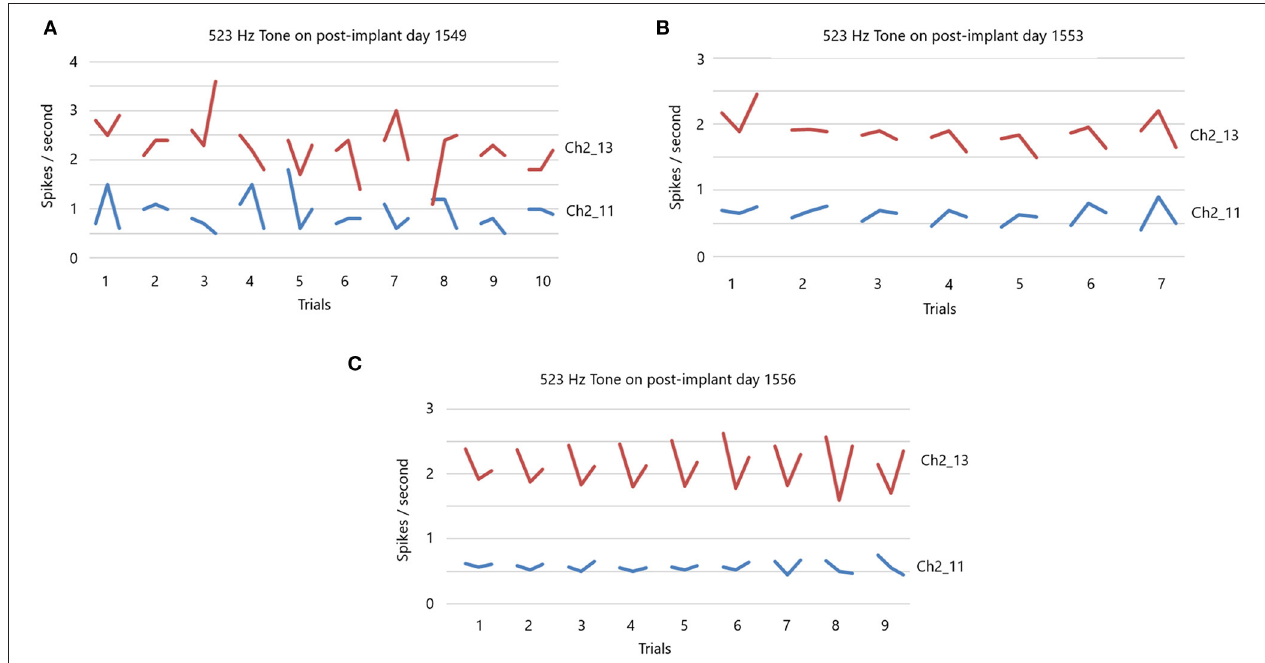
FIGURE 7 | (A) 523Hz tone is presented on post-implant day 1,549. There are 10 trials, with each trial having a 10s “listen” period, followed by a 10s rest period and then a 10s “sing the tone he just heard” period. Note the random firing rates of these slow participant. There is no feedback during this session. (B) 523Hz tone is presented on post-implant day 1,553. Same paradigm as in (A) for seven trials. There is feedback of the firing rate. Note the less random firing rates. (C) 523Hz tone is presented on post-implant day 1,556. Same paradigm as in (A) for nine trials. There is feedback of the firing rates that is dependent on the feedback volume of the firing rates. Note the non-random firing